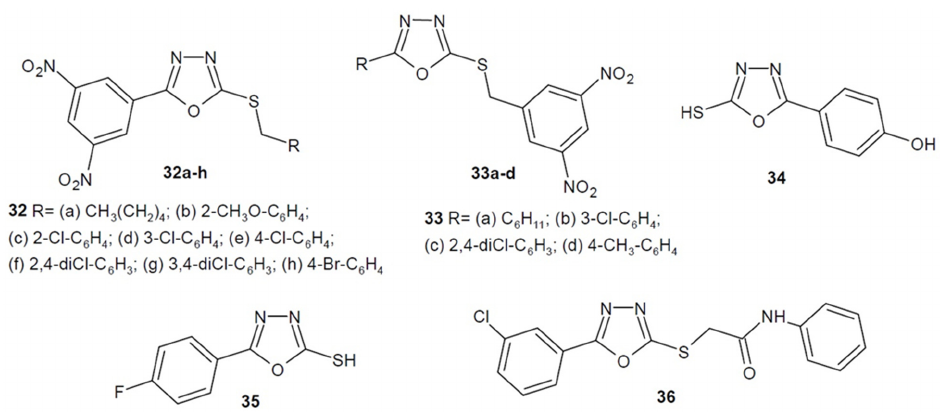
Figure 13. Simple 1,3,4-oxadiazole-2-thiols and their S -substituted derivatives with antibacterial activity. Among more complex molecules, Rezki et al. (2015) received a series of symmetri- cally 2,5-disubsituted-thiadiazoles derivatives hybridized with a triazole, thiadiazole or oxadiazole. Compound 37 (Figure 14) with the free thione group at position 2 of 1,3,4- oxadiazole, showed the strongest antibacterial activity against P. aeruginosa , S. pneumoniae newly synthesized structures possess anti-proliferative potential [71].